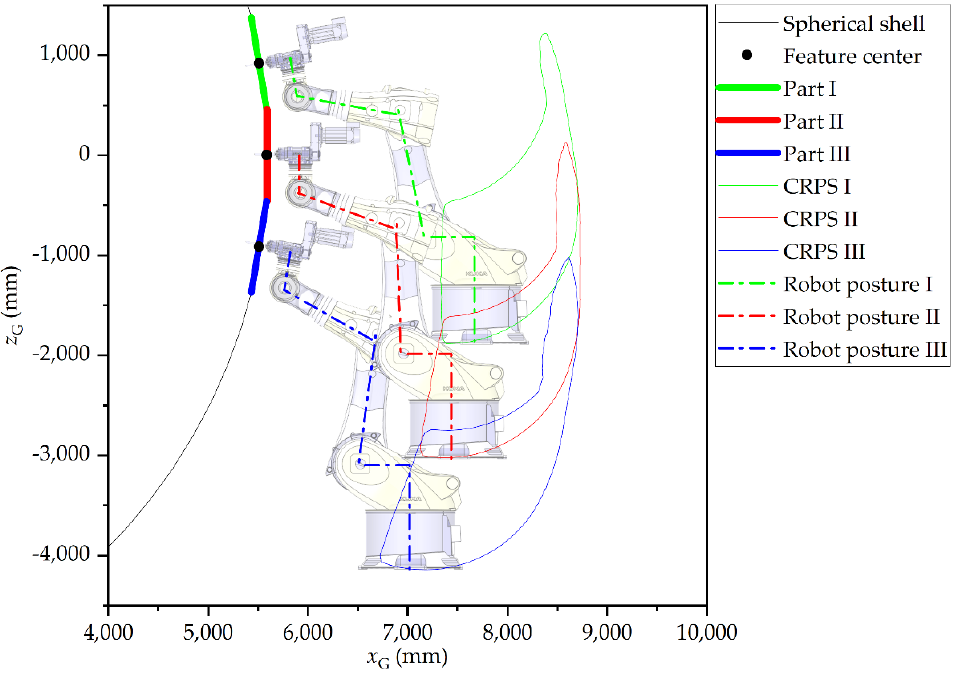
Figure 9. Placement space meeting constraints of position and posture.